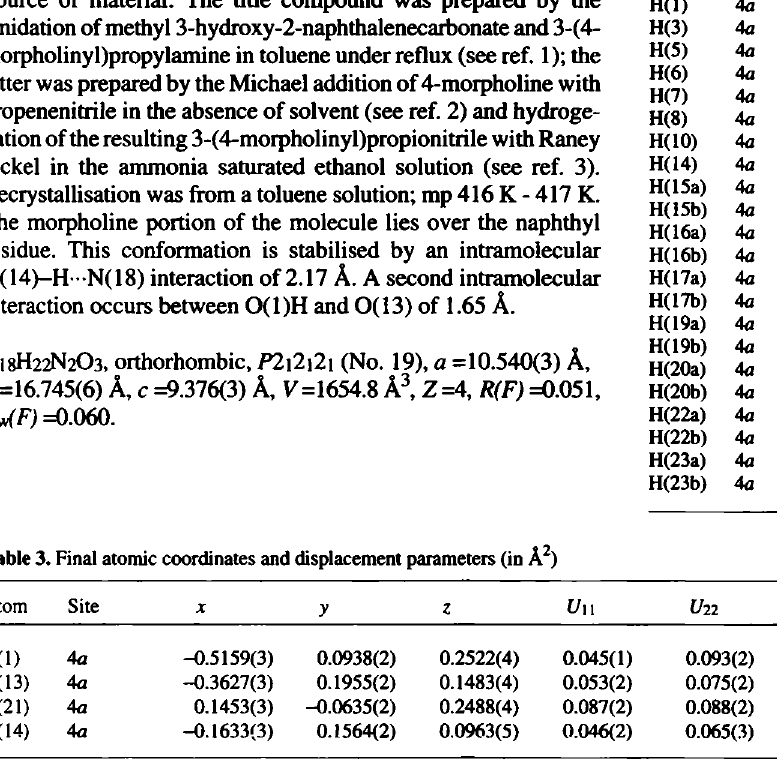
Table 2. Fmal atomic coordinates and displacement parameters (in Â^)